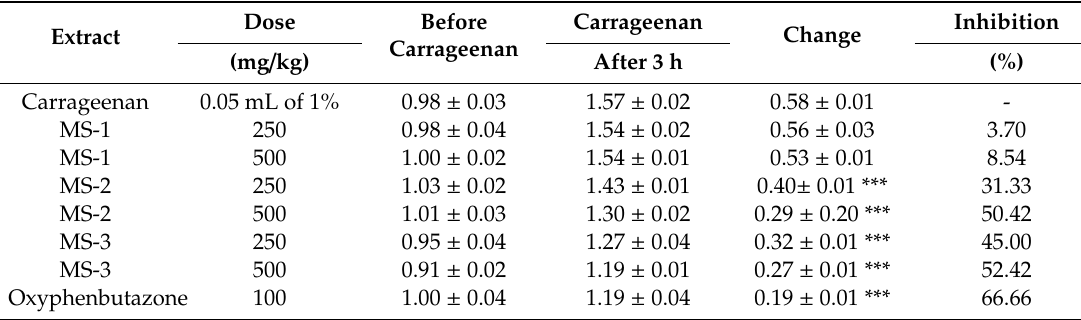
Table 5. E ff ects of M. sinaica fractions on carrageenan-induced paw edema in Albino rats. Dose Before Extract Carrageenan